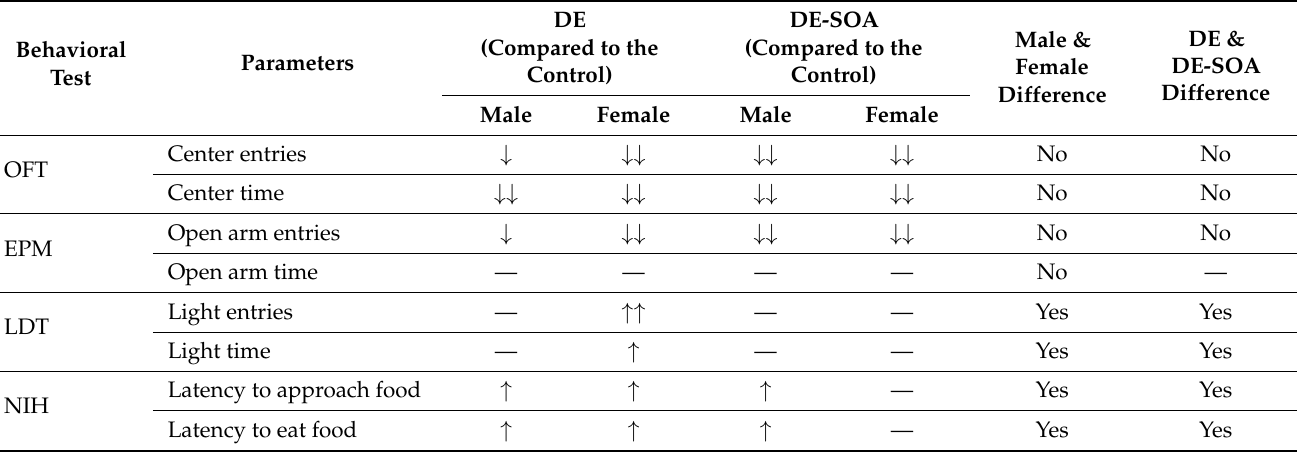
Table 1. Summarized results of comparison of anxiety-like behavioral tests between DE and DE-SOA in male and female rats.